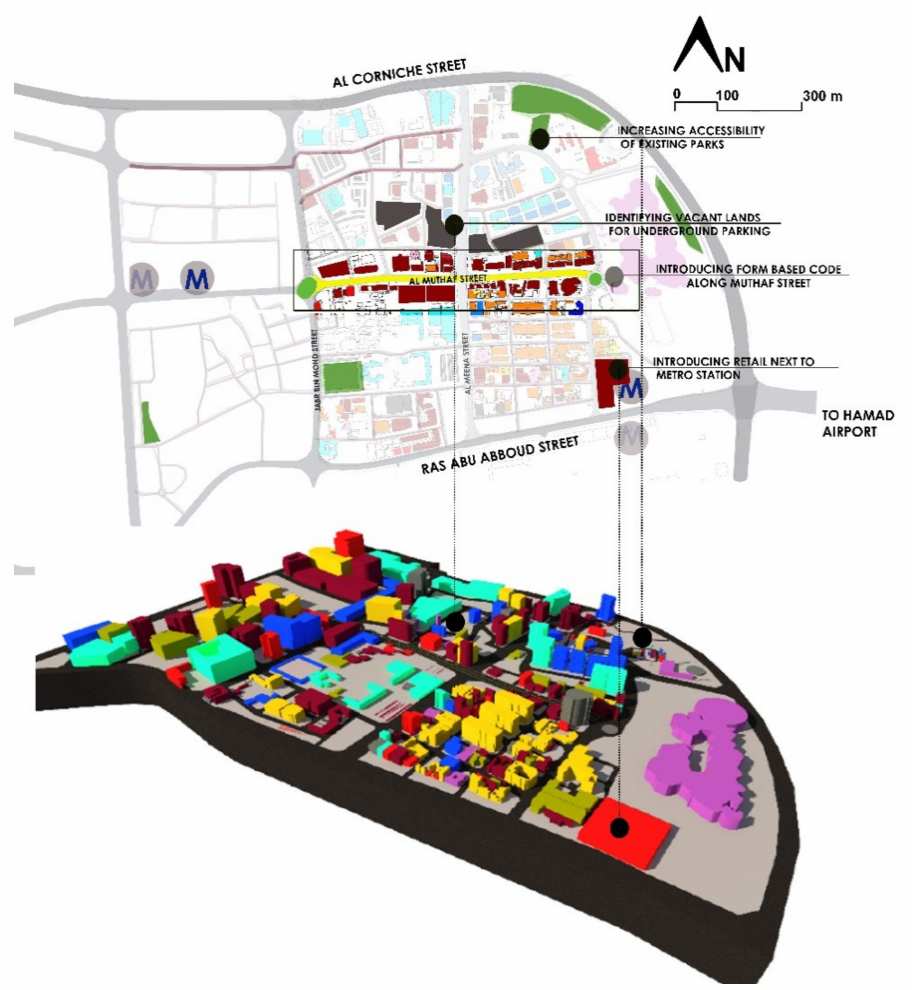
Figure 9. Proposed masterplan—Muthaf